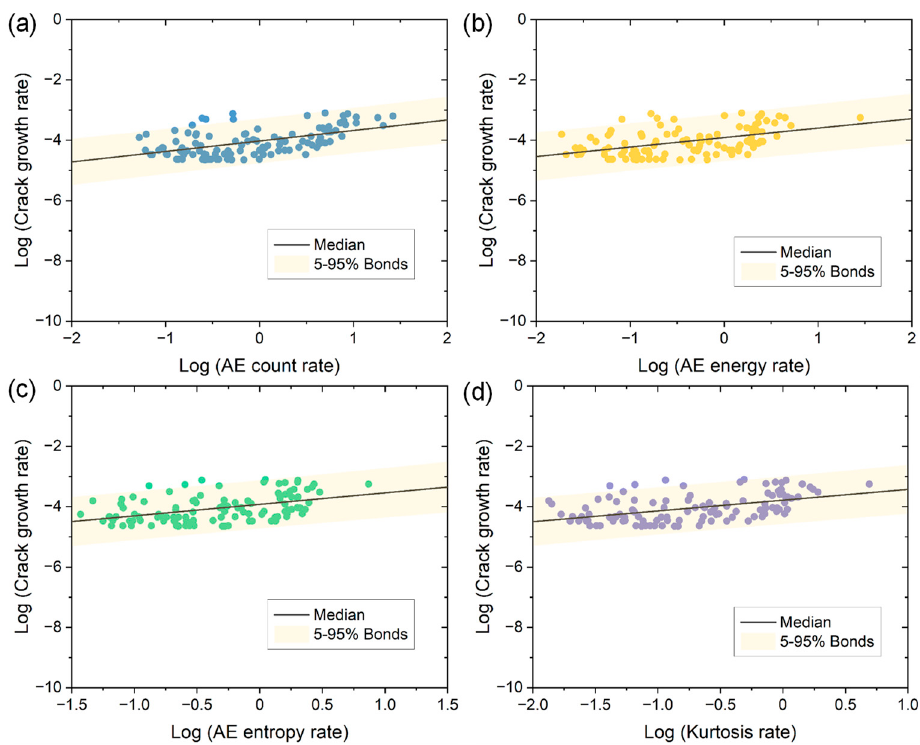
Figure 10. The logarithm of crack growth rate versus the logarithm of ( a ) AE count rate, ( b ) energy rate, ( c ) entropy rate, and ( d ) kurtosis rate of two specimens. The linear regression results including the median and the 95% prediction interval are also included.